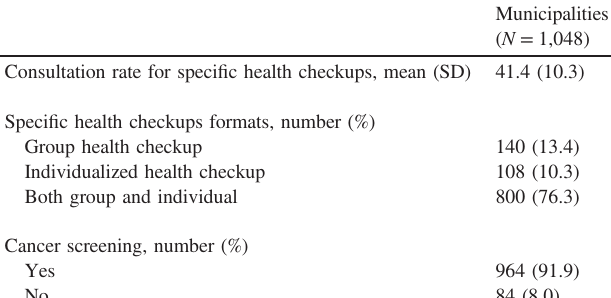
Municipalities ( N =